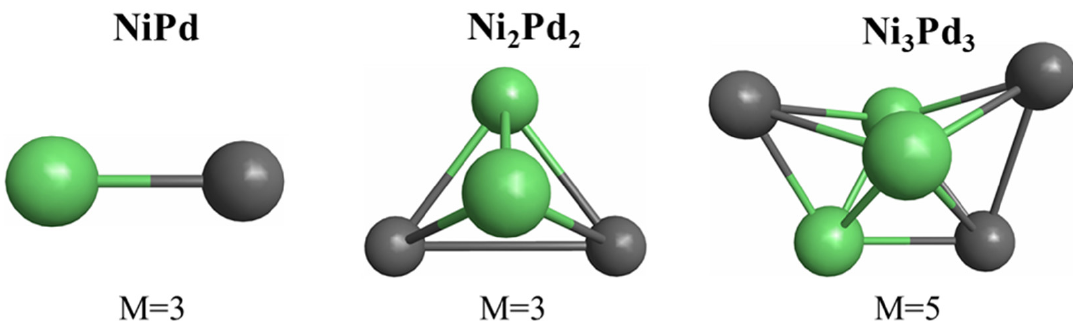
Figure 2. Ground-state structures of the Ni n Pd n (n = 1 − 3) clusters and their respective spin multi- plicities (M).